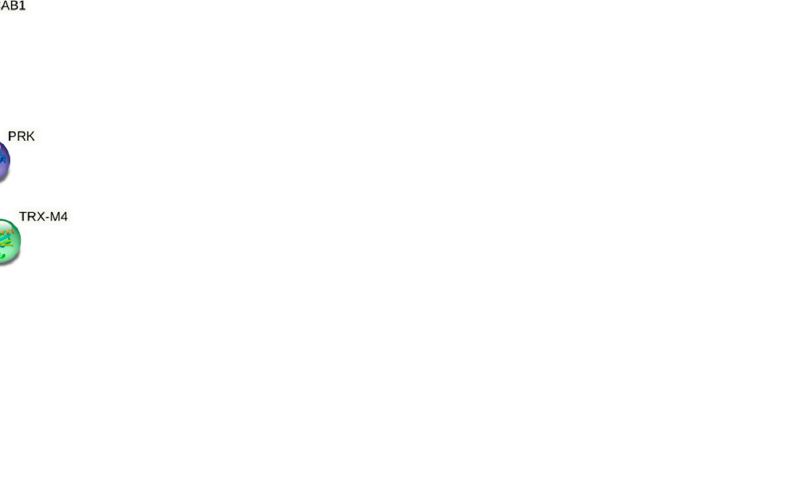
Figure 5. Protein interaction map of eight differential proteins (CAB1, PRK, LHCA3, TRX-M4, CA1, PETC, and At2g03440) established by employing STRING database.